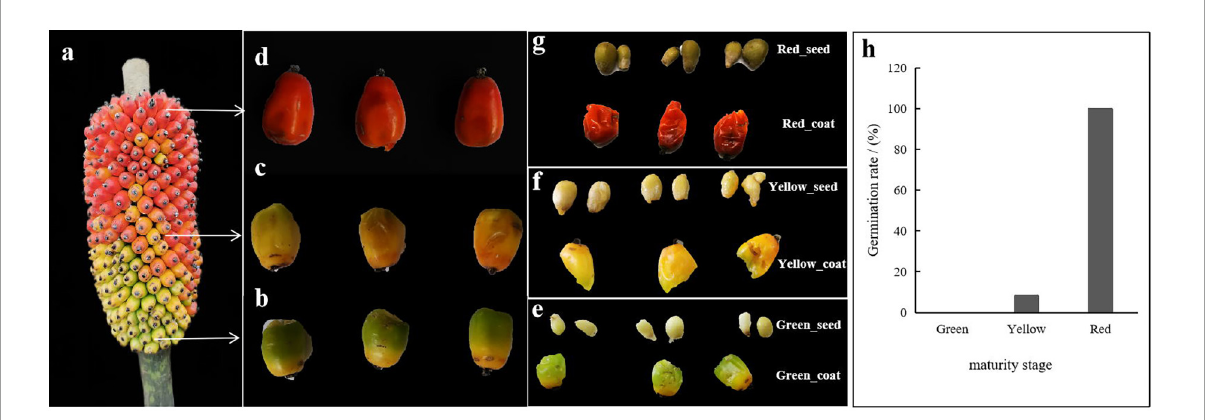
FIGURE1 (a) Amorphophallus muelleri seed-bearing plant. (b) Immature-stage seeds (green). (c) Intermediate-stage seeds (yellow). (d) Fully mature seeds (red). (e) Separated green external coat and internal seed. (f) Separated yellow external coat and internal seed. (g) Separated red external coat and internal seed. (h) Germination rate of seeds with different maturation durations (green seeds: 0%; yellow seeds: 8.33%; red seeds: